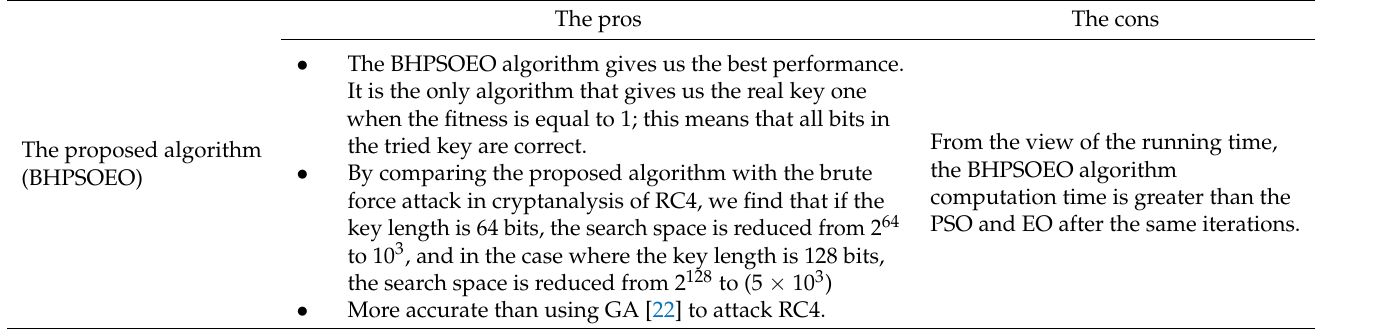
Table 5. The pros and cons of our